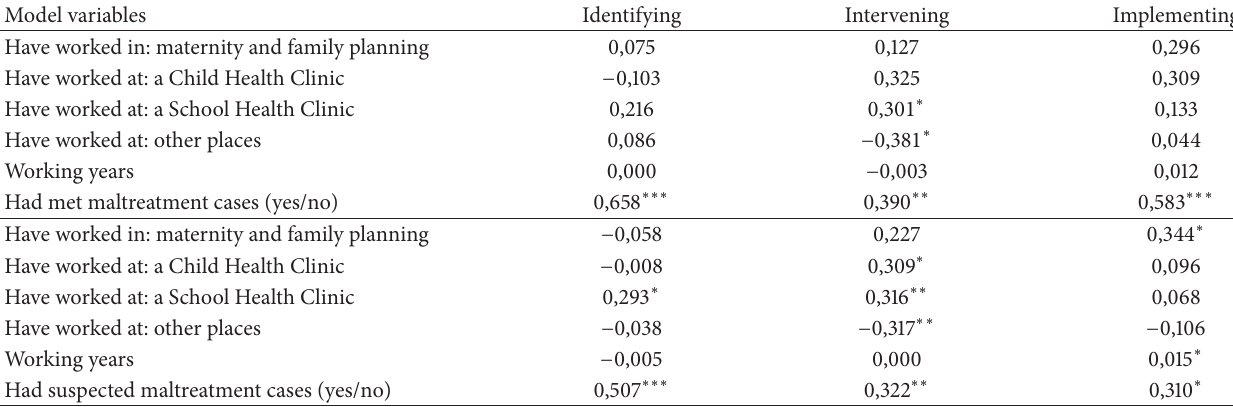
Table 4: The effects of separate background factors on identifying, intervening , and implementing . Variables Identifying Intervening Implementing ∗∗ Age (correlation, significance) 0,01 NS 0,01 NS 0,1 4 Working years as a nurse (correlation, significance) − 0,02 NS − 0,03 NS 0,07 NS Working in urban areas/countryside/both (ANOVA sig.) NS NS NS Knowledge of the existence of a guideline ( 𝑡 -test sig.) ∗ ∗ ∗ ∗ ∗ ∗ ∗ ∗ ∗ PHN had read the guideline ( 𝑡 -test sig.) ∗ ∗ ∗ ∗ ∗ ∗ ∗ ∗ ∗ PHN had had education on the topic (ANOVA sig.) ∗ ∗ ∗ ∗ ∗ ∗ ∗ How many (0, 1 − 4, 5, or more) child maltreatment cases they had met during six ∗ ∗ ∗ ∗ ∗ ∗ months (ANOVA sig.)